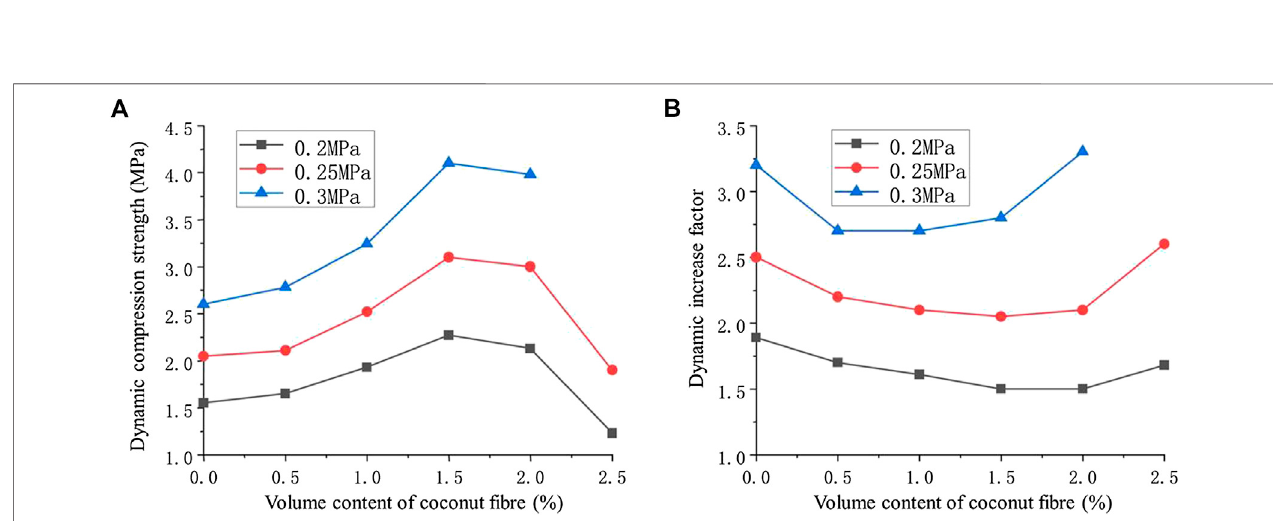
FIGURE 7 | Dynamic compression strength and dynamic increase factor (A) Dynamic compression strength (B) Dynamic increase